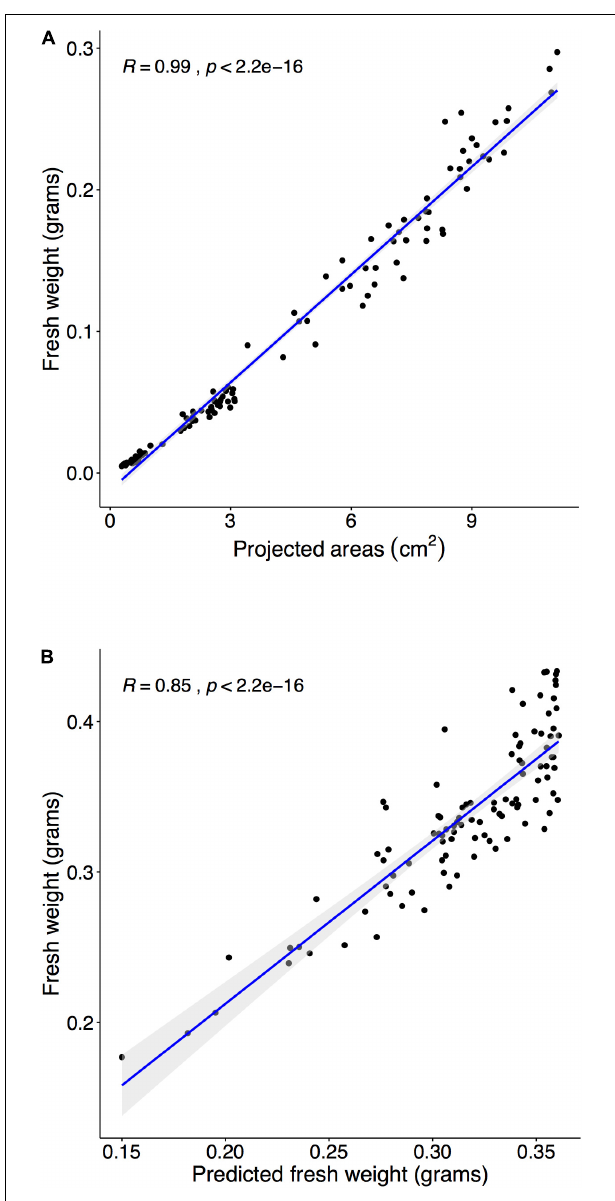
FIGURE 6 | Estimating fresh weight (FW) from the PA and predict FW with three training sets. Panel (A): Harvest and weight 110 plants within the pre-flowering stage (15, 18, and 20 DAS), and we compared measured FW and PA from the image analysis. The correlation between FW and PA was tested using Spearman’s rank correlation coefficient ( R ). The coefficient’s ( R ) confidence level at 95% was shaded in gray. (A) Comparison of PA and FW in the range of 14–21 DAS ( R = 0.9904). (B) Randomly select 30 samples at experiment II and predicted PAs with training 3 model and then converted into estimated FW. Compared estimated FW and measured FW at 23 DAS ( R =